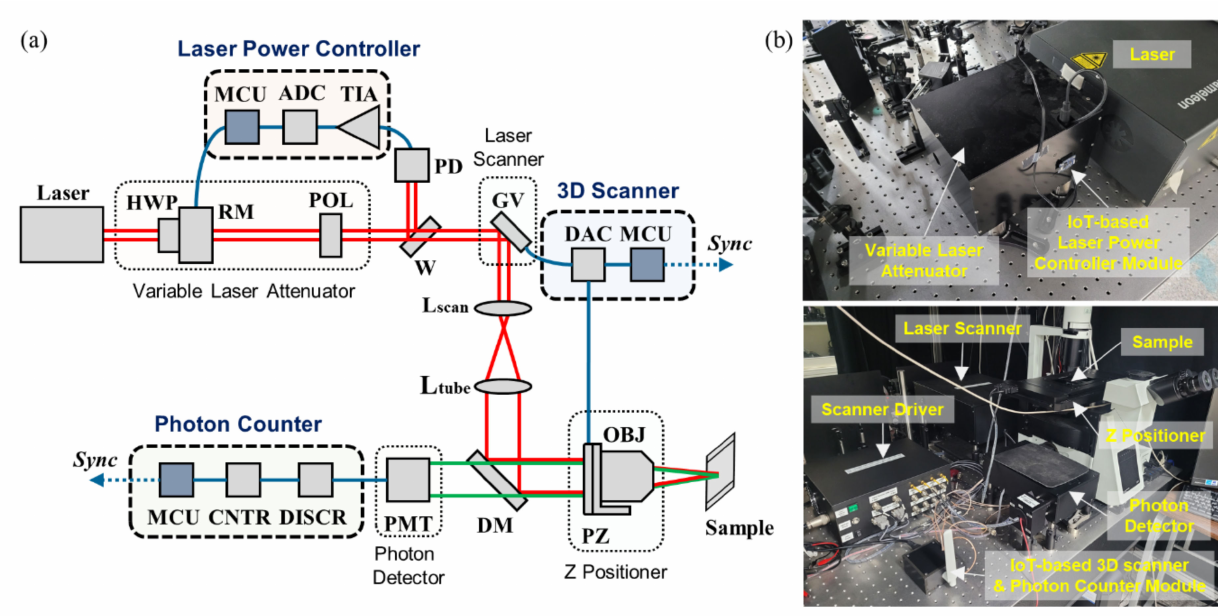
Figure 1. ( a ) Hardware configuration of the Internet of Things two-photon laser scanning microscopy (IoT-TPLSM). ( b ) Photograph of the customized modules. HWP: half-wave plate; RM: rotary motor; W: optical window; PD: photodiode; TIA: trans-impedance amplifier; GV: galvanometer mirror; L: optical lens; DM: dichroic mirror; PZ: piezo stage; OBJ: objective lens; PMT: photomultiplier tube; DISCR: discriminator; CNTR: pulse counter; MCU: microcontroller